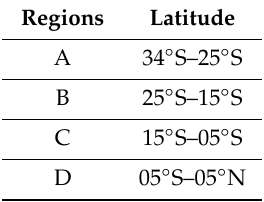
Figure 2. Brazilian coastline and the main marine areas delimited. Table 1. Regions of the Brazilian coast considered in this study.